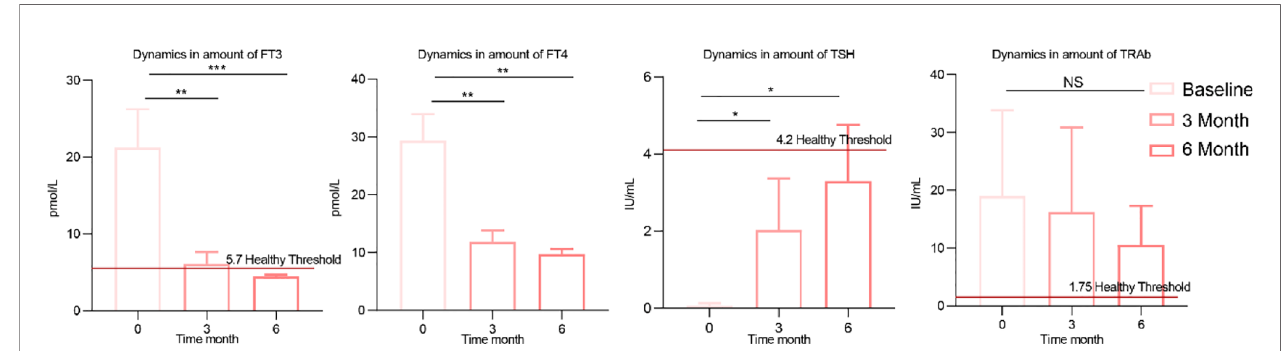
FIGURE 3 | Changes in clinical indicators after berberine combined with methimazole treatment. The concentrations of thyroid indicators such as free triiodothyronine (FT3), free thyroxine (FT4), thyroid-stimulating hormone (TSH), and thyroid-stimulating hormone receptor antibodies (TRAb) at baseline, 3 months of treatment and 6 months of treatment. The differences in the levels of thyroid indicators between the two groups were compared using the Kruskal-Wallis test, and the differences between the two groups were statistically signi fi cant. Asterisks indicate signi fi cant differences between baseline and endpoints in the corresponding groups (***P < 0.001, **P < 0.01, *P < 0.05) NS means there is no signi fi cant difference between the two groups, error line means ±